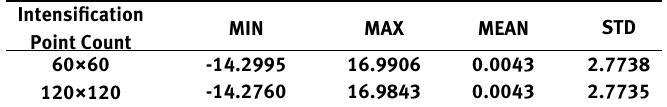
Table 2. Results of Improved Method /Unit: